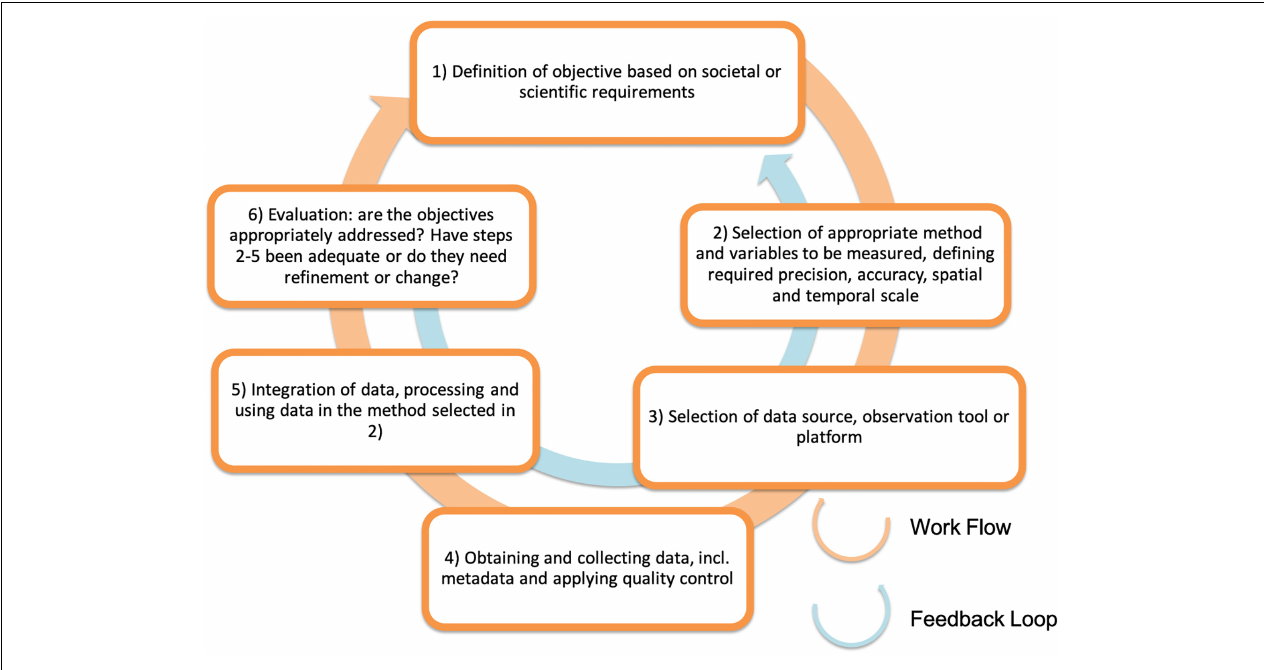
FIGURE 5 | An ocean observing supply